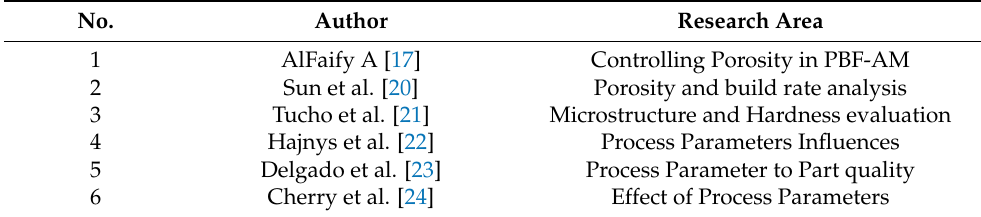
Table 1. Parameter collection for density of SS316L by AM.